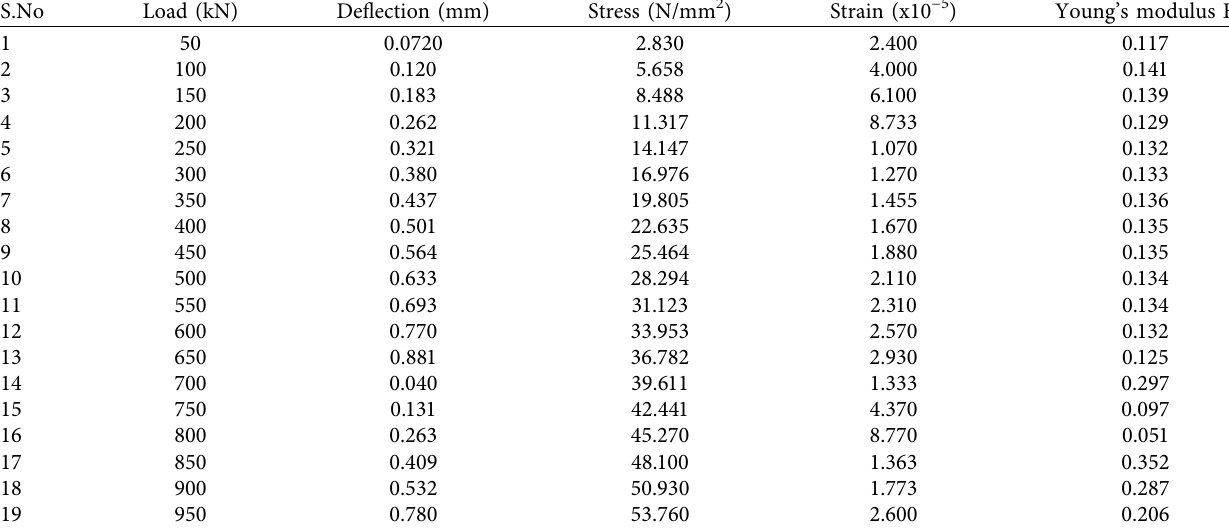
Table 9: Young’s modulus for M40 grade of column with 5mm